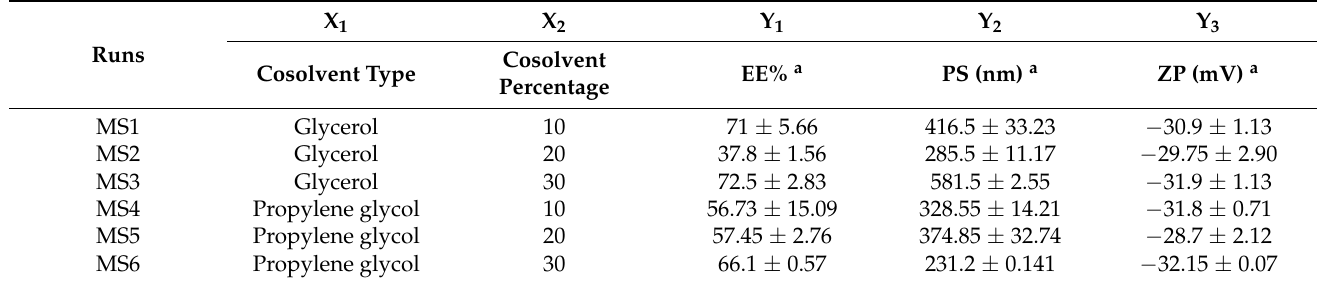
Table 5. Experimental runs, independent variables, and measured responses of 3 1 .2 1 full factorial experimental design of TOL-cosolvent spanlastics.